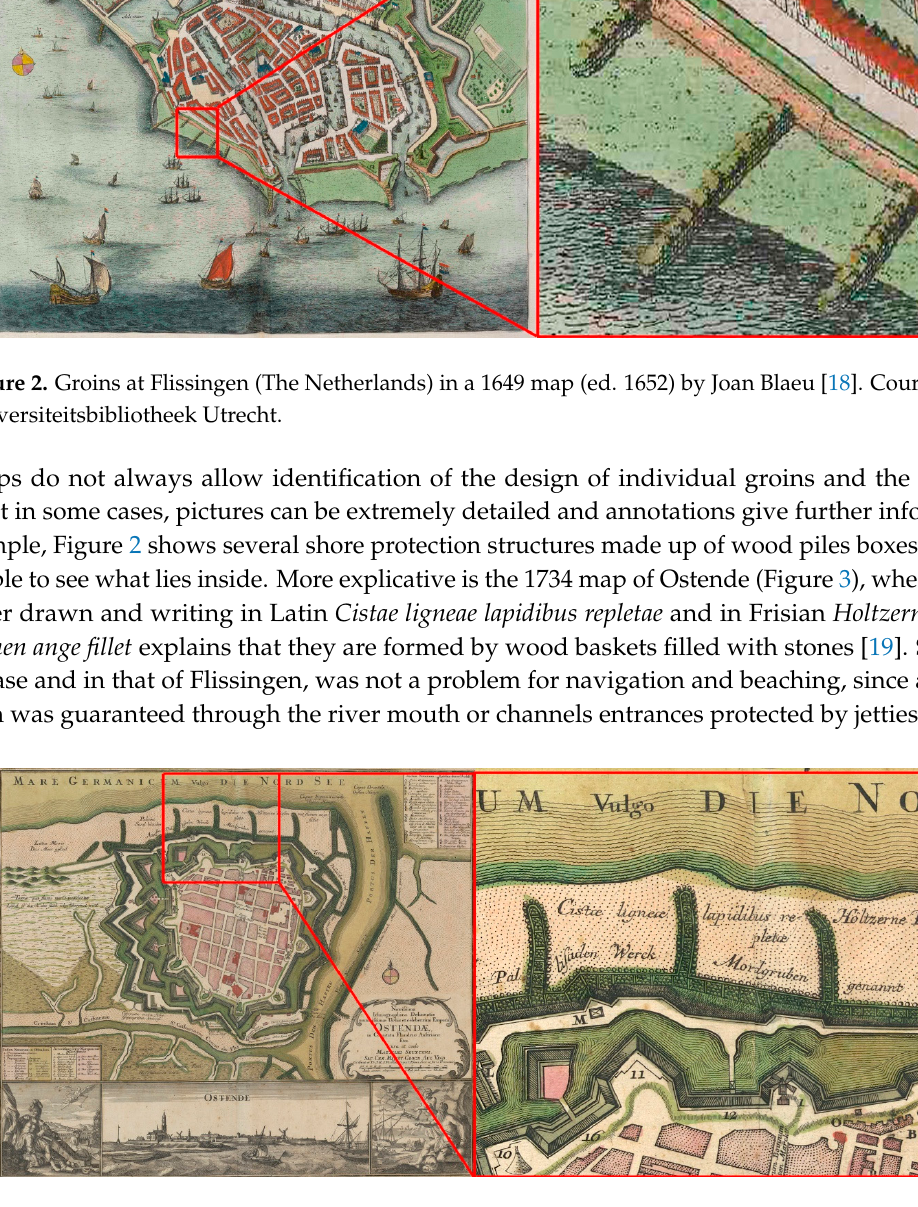
Figure 3. Ostende in a 1734 map by Seutter [20] (detail on the right).